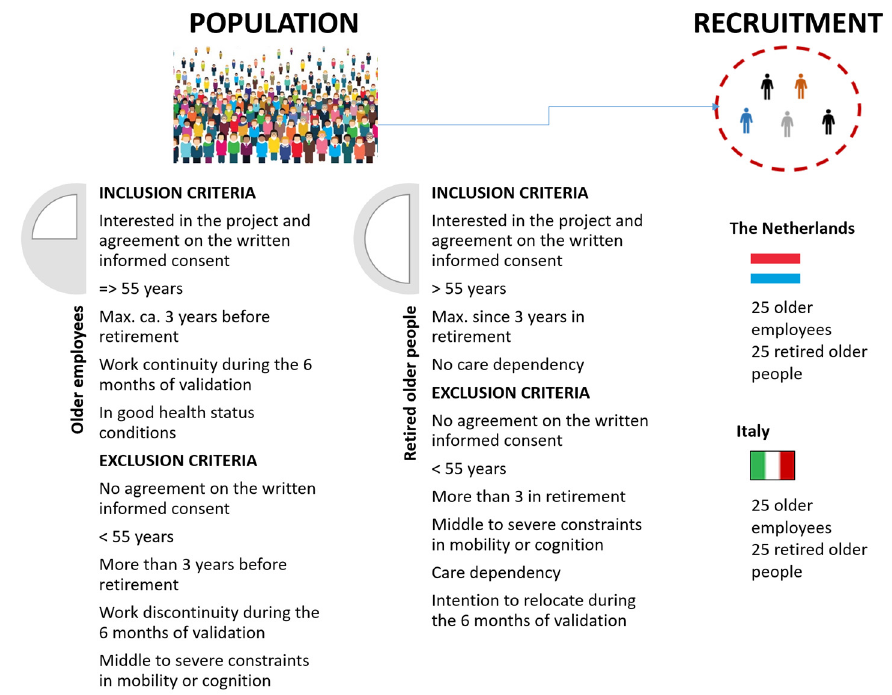
Figure 5. Recruitment Procedure.